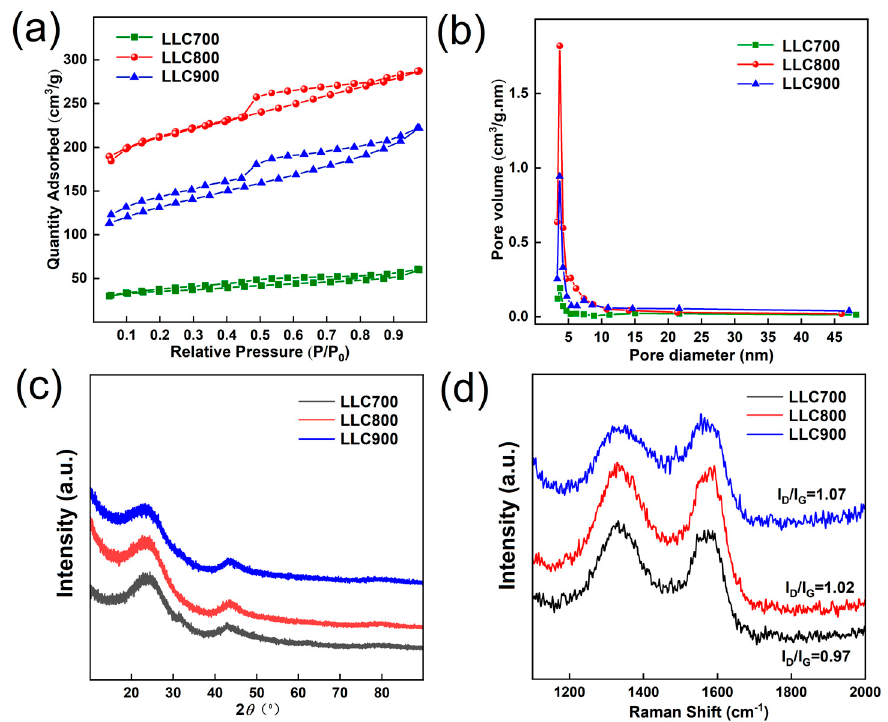
Figure 2. Nitrogen adsorption-desorption isotherms ( a ), pore size distribution ( b ), XRD ( c ) and Raman spectra ( d ) of LLCs at different pyrolysis temperatures.